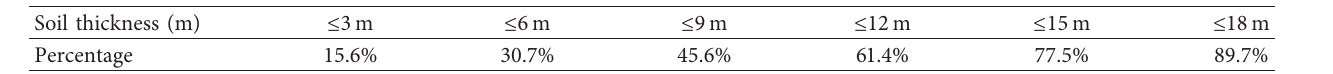
Table 7: Statistical table of the soft soil thickness along lines.